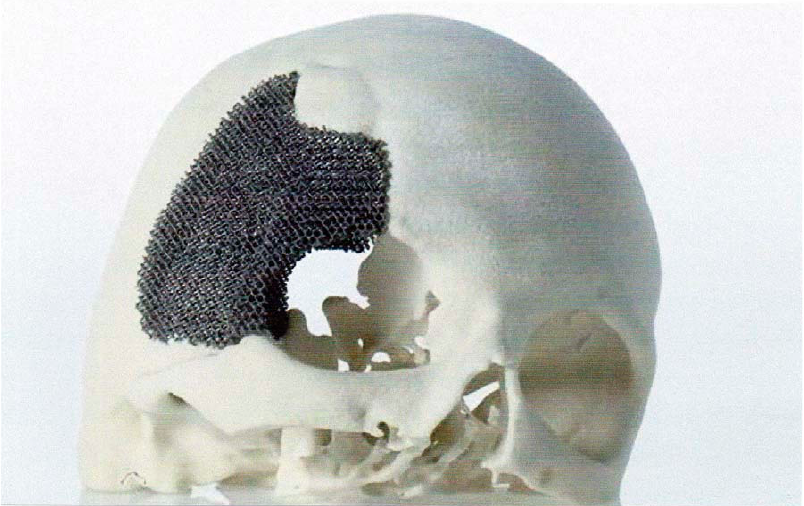
Figure 8. Rhombic dodecahedral element reticulated Ti-6Al-4V mesh skull replacement prototype fabricated by EBM. Reprinted with permission from Ref. [150]. Copyright 2017, copyright Murr L E.